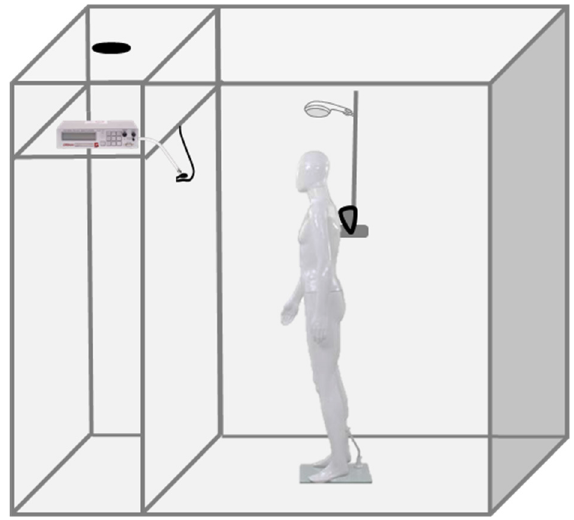
Figure 1. A schematic representation of the experimental shower stall showing the locations of sampling instruments and the air-extraction system (black hole).